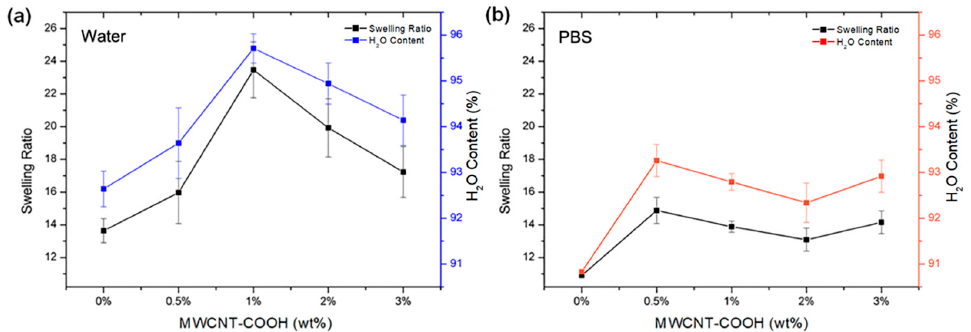
Figure 4. Swelling ratio and water content of PNIPAM/MWCNT-COOH hydrogels as a function of nanotube concentration in ( a ) pure water and ( b ) PBS solution at 25 °C.